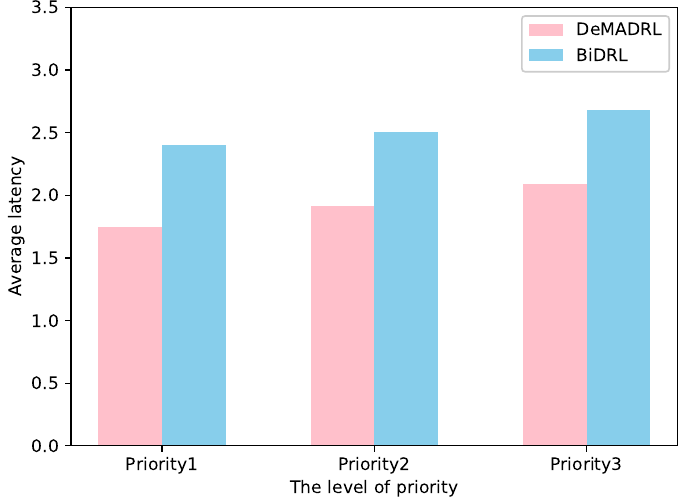
Figure 8. Average delay of two learning algorithms with three-level priorities.